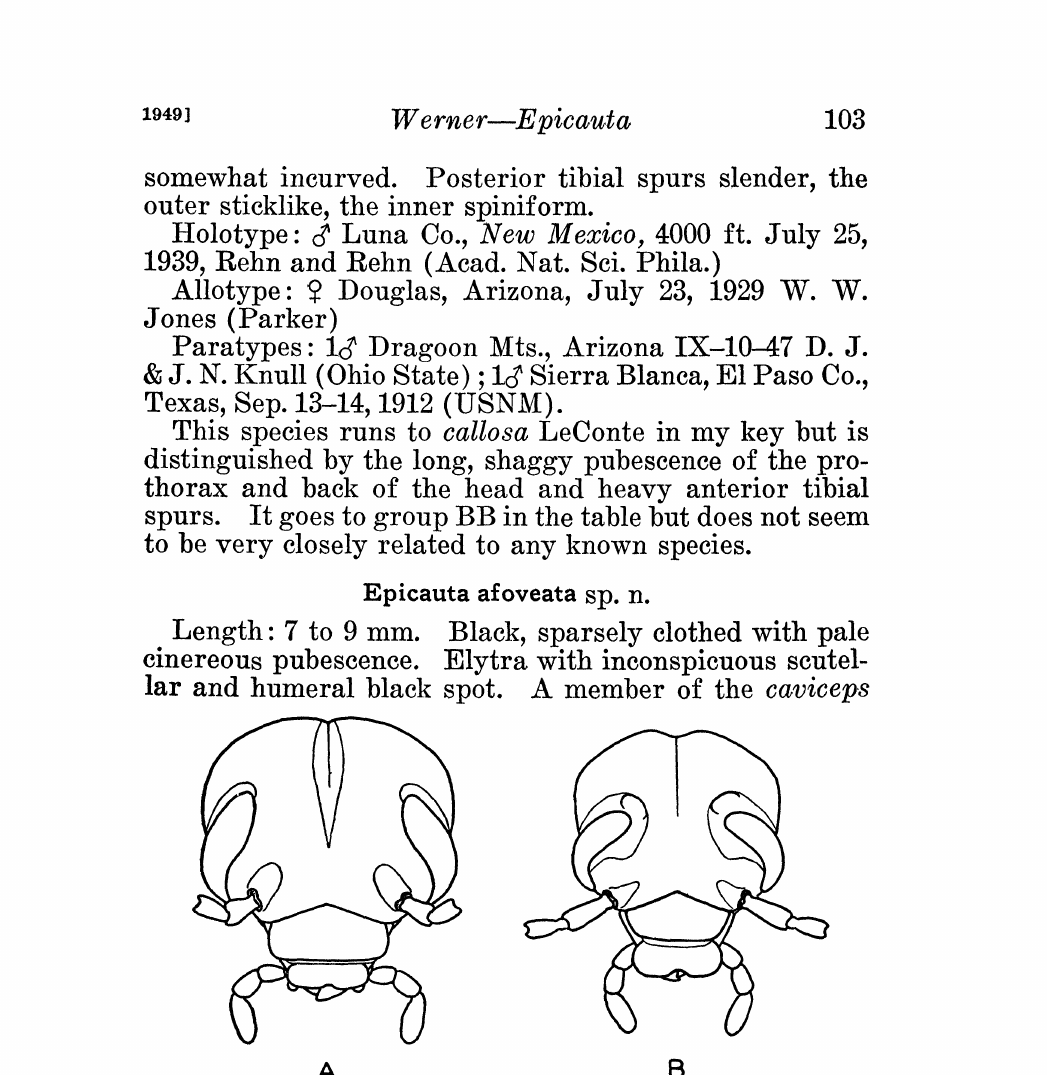
Fig. 2. A. Head of Epicauta afoveata sp. n. B. Head of Fpicauta ira. pressifrons